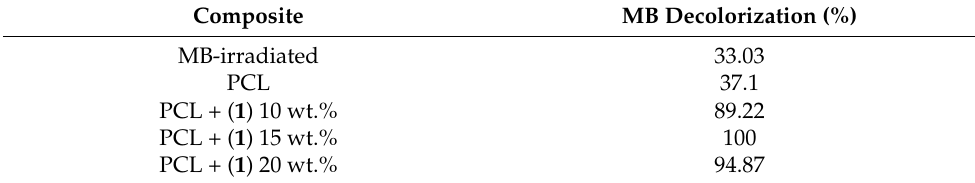
Figure 6. UV–Vis DRS spectra of PCL and studied PCL + ( 1 )